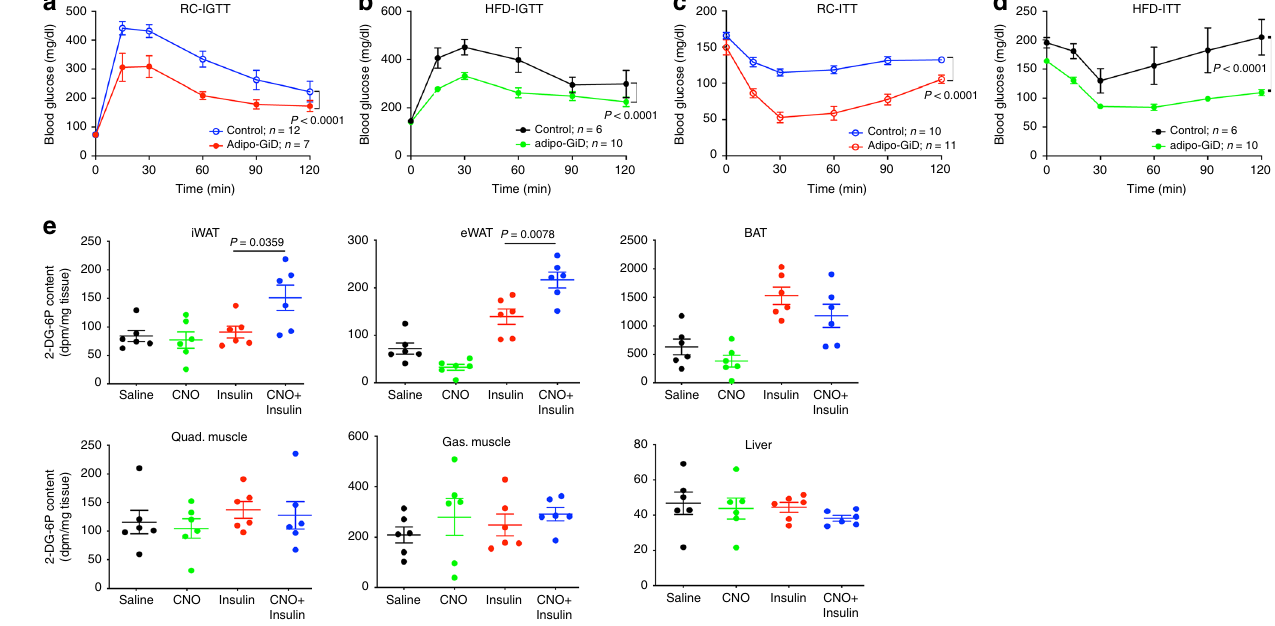
Fig. 9 Activation of adipocyte G i signaling improves glucose metabolism and insulin sensitivity. Adipo-GiD mice and control littermates (adult males) were subjected to a series of metabolic tests. a , b I.p. glucose tolerance test (IGTT) (RC, regular chow: 10 mg/kg CNO + 2 g/kg glucose; HFD: 10 mg/kg